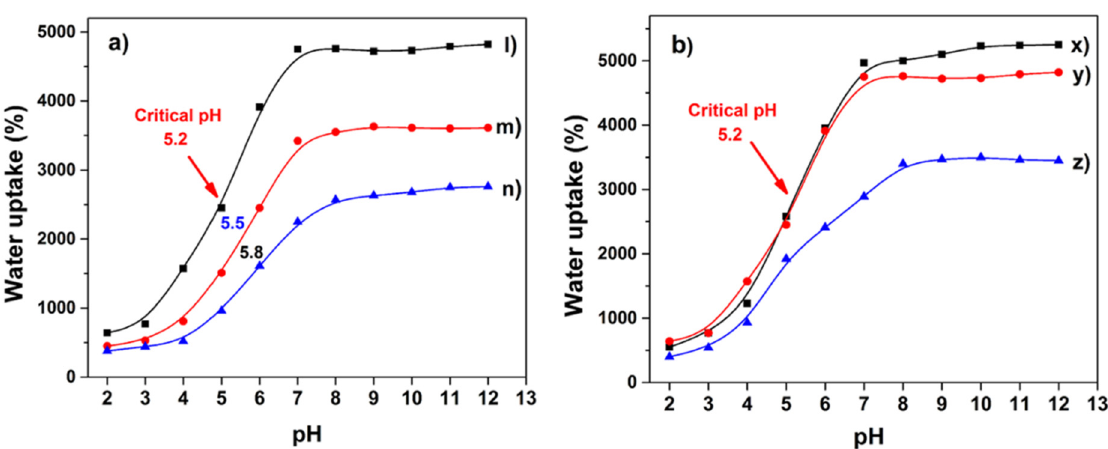
Figure 9. ( a ) . Critical pH of hydrogels in PBS as a function of AAc amount (l) 1, (m) 1.5, and (n) 2 mL, irradiated at 20 kGy. ( b ). Swelling profile of hydrogels obtained at different irradiation dose (x) 15, (y) 20, and (z) 25 kGy, respectively, using 1 mL of AAc for these samples.